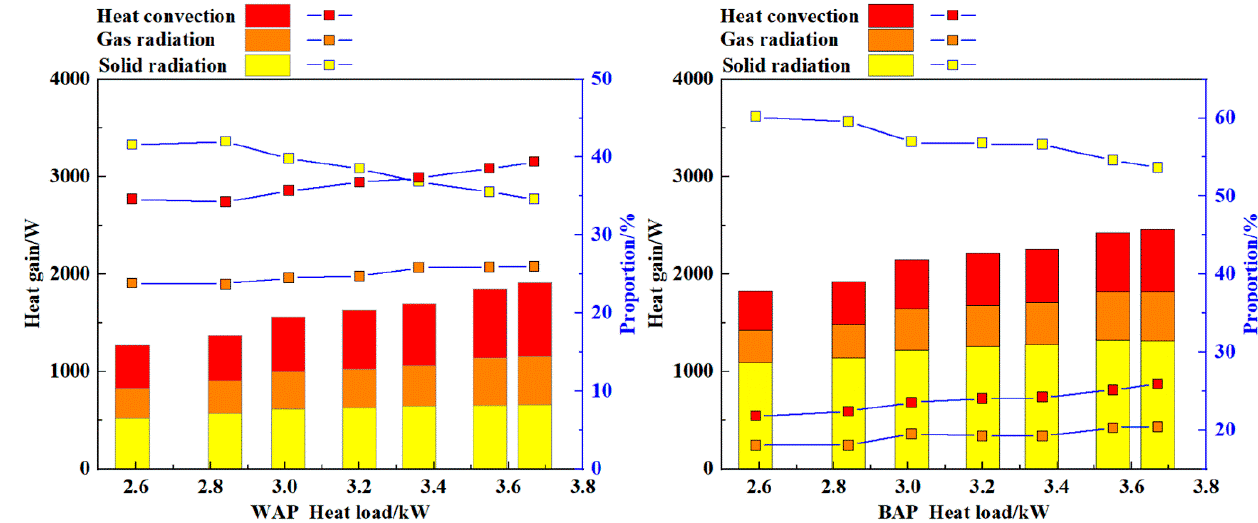
Figure 7. Heat gain of BAP and WAP under different heat loads.